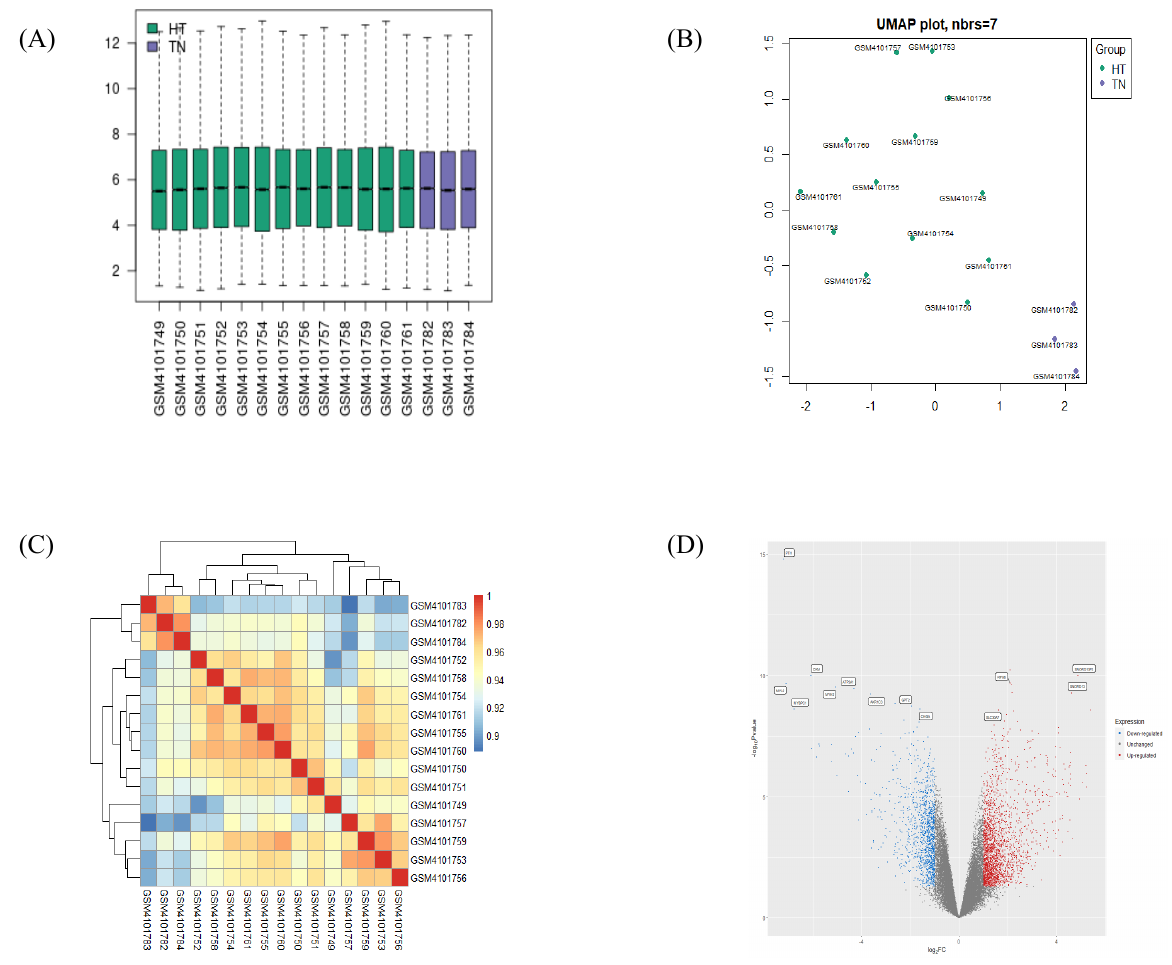
Figure 1. Validation of selected gene-expression profiles from GSE138198. A total of 16 human sam- ples were included, 13 in the HT group and 3 in the TN group. ( A ) Boxplot displays distributions of values of the selected samples from GSE138198 after normalization. ( B ) UMAP plot of 16 normalized samples embedded in a Euclidean space. ( C ) Clustered correlation heatmap showing correlation of microarray profile between 16 samples. ( D ) Volcano plot of significant differentially expressed genes (DEGs) in HT (adjusted p -value < 0.05 and |log 2 FC| > 1). Plots were created by using GEO2R or pheatmap R